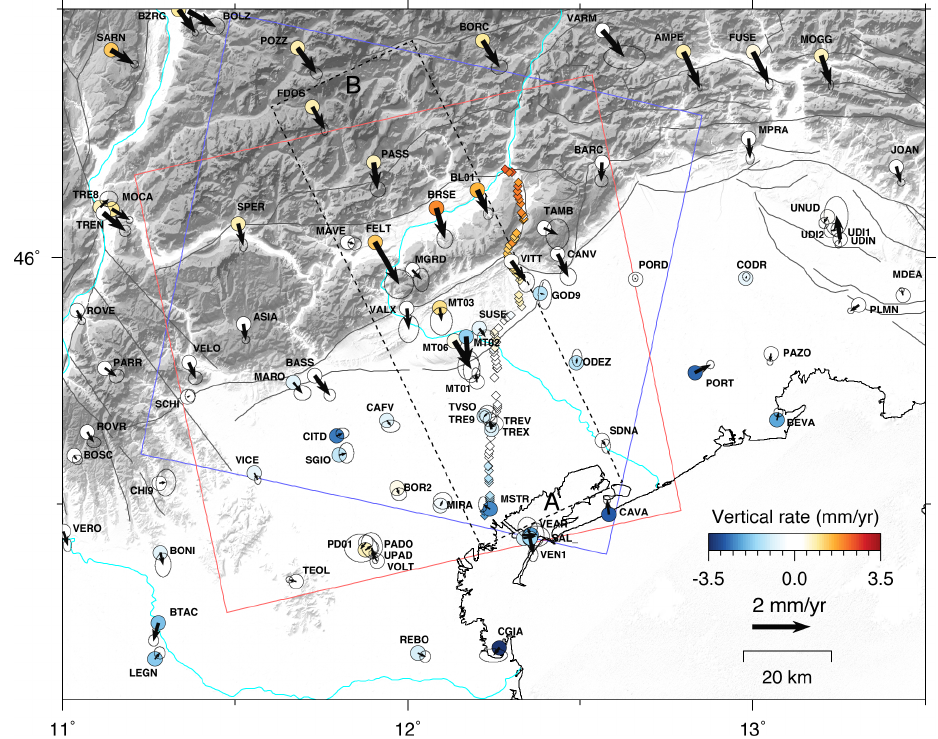
Figure 2. Geodetic dataset: the black arrows show the horizontal GPS velocities (with 95% error ellipses) in a fixed-Adria reference frame, whereas the colored circles show the vertical GPS velocities, where blue colors indicate negative (subsidence) values and red colors indicate positive (uplift) values. The colored diamonds show the vertical ground motion rates estimated from the IGMI leveling data in the 1952–1984 time interval, using the same color scales as the GPS velocities. The blue and red squares indicate the ascending and descending ENVISAT frames, respectively, used in this work. The dashed box shows the A–B cross section shown in Fig.